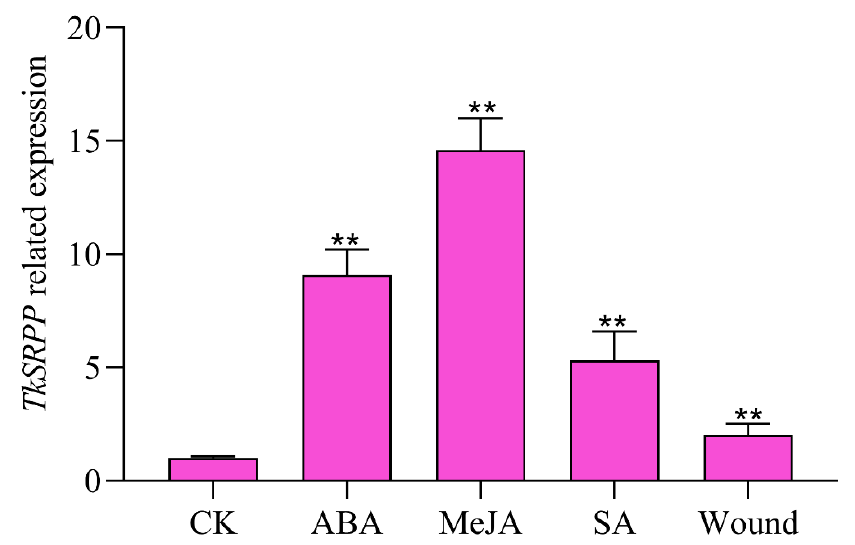
Figure 6. TkSRPP expression profile in T. kok-saghyz under multiple stresses. To evaluate the TkSRPP expression profile, T. kok-saghyz was treated by ABA, MeJA, SA and wound for six hours, and the TkSRPP expression was analyzed by qRT-PCR. GAPDH were used as reference genes. Compared with the control (CK), the SRPP relative expression of the treatment groups was calculated by the 2 − ∆∆ Ct method in biological triplicates (n = 3). The bars represent standard errors and the asterisks indicate statistical significance determined by the Student’s t -test (** p ≤ 0.0 1).